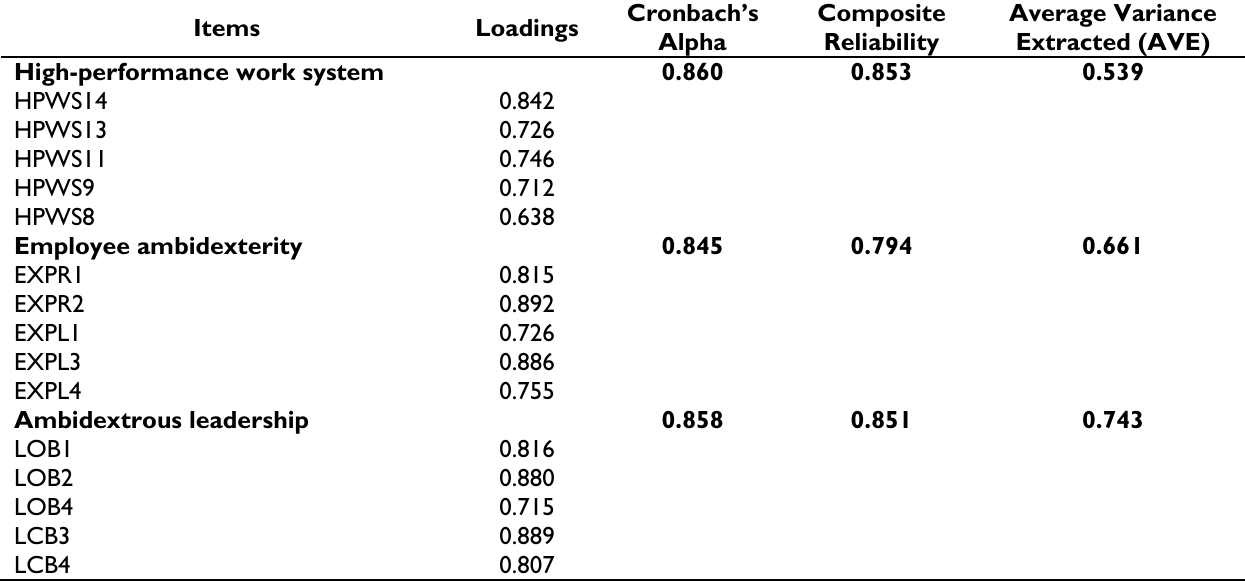
Table 4. Loadings, Reliability, and Convergent